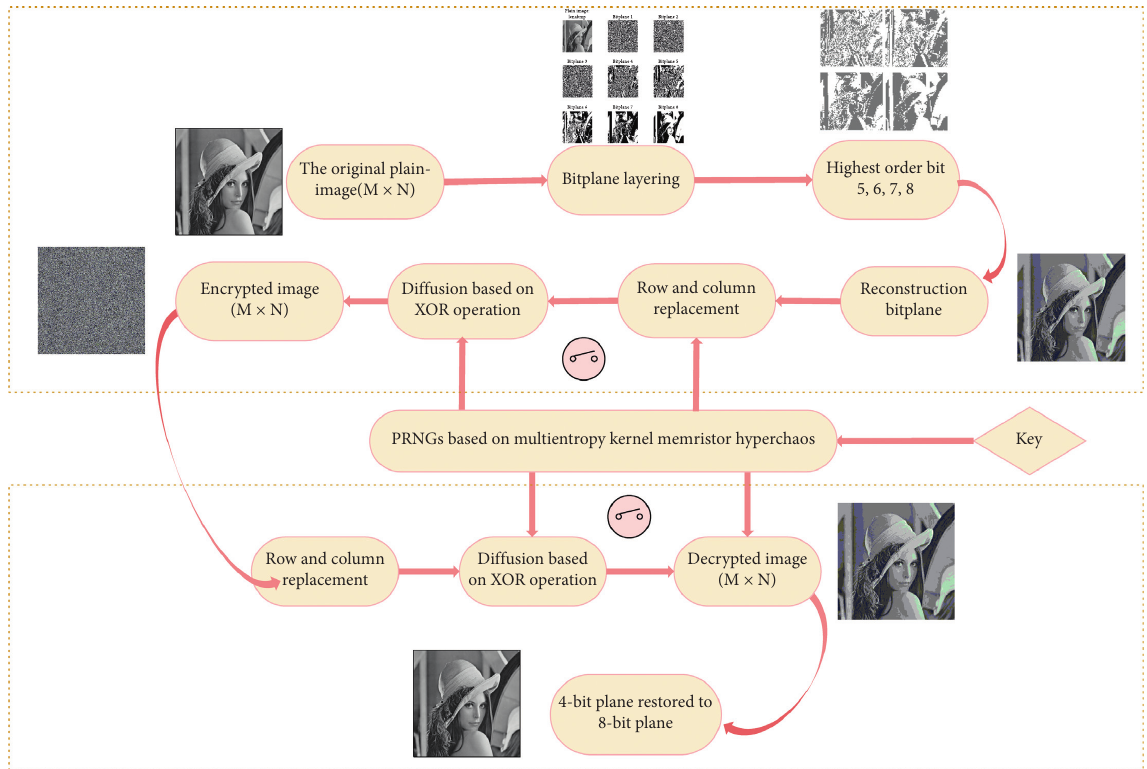
Figure 12: Proposed chaotic digital image cryptography system.